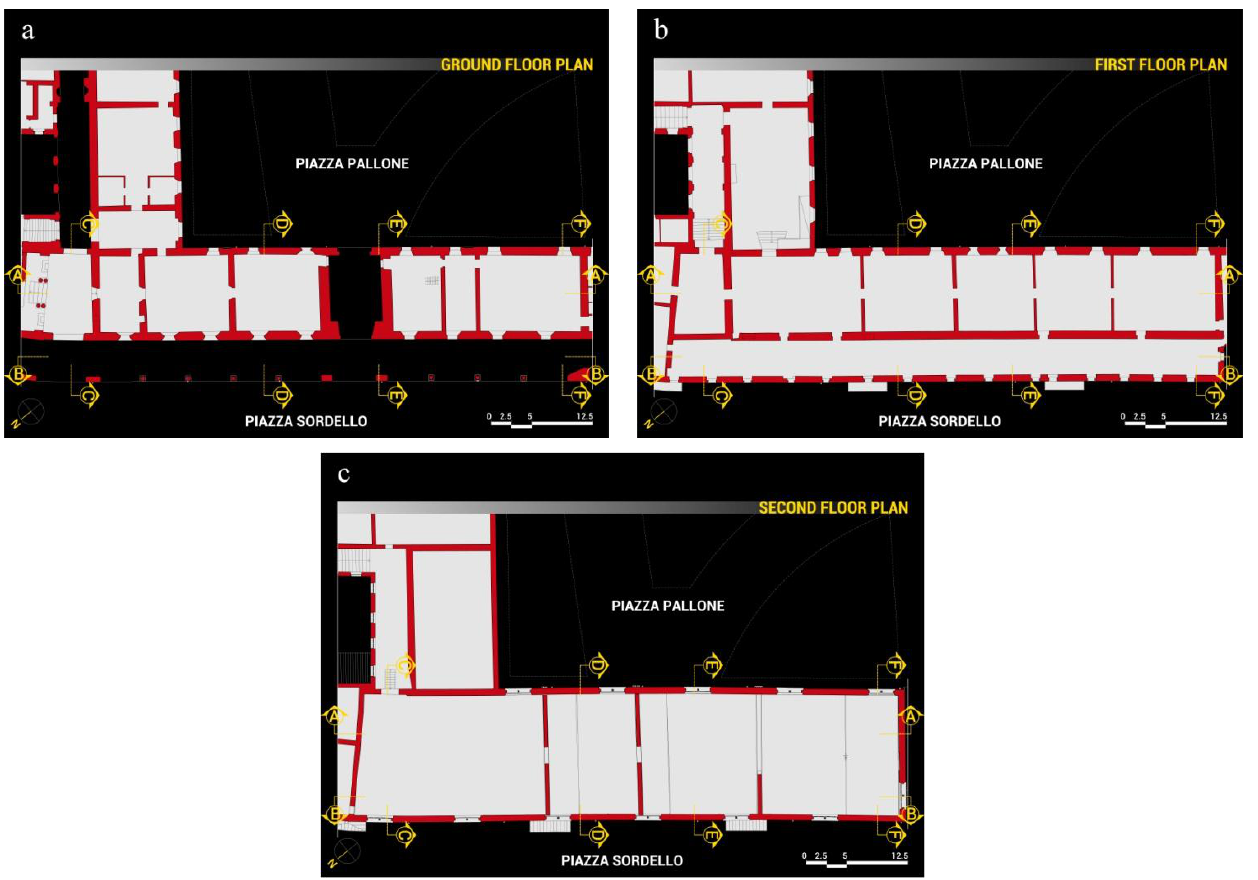
Figure 2. Palazzo del Capitano plans ( a ) Ground floor plan. ( b ) First floor plan. ( c ) Second floor plan.